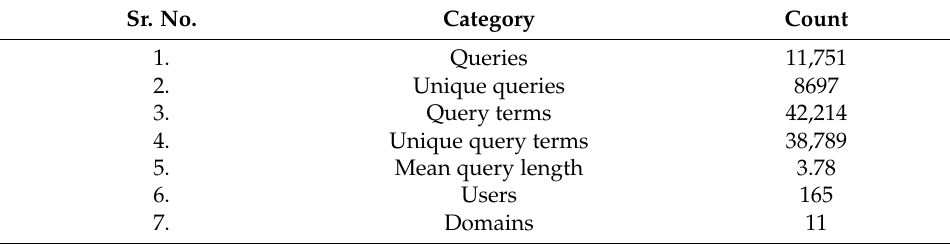
Table 1. Urdu web queries dataset statistics.